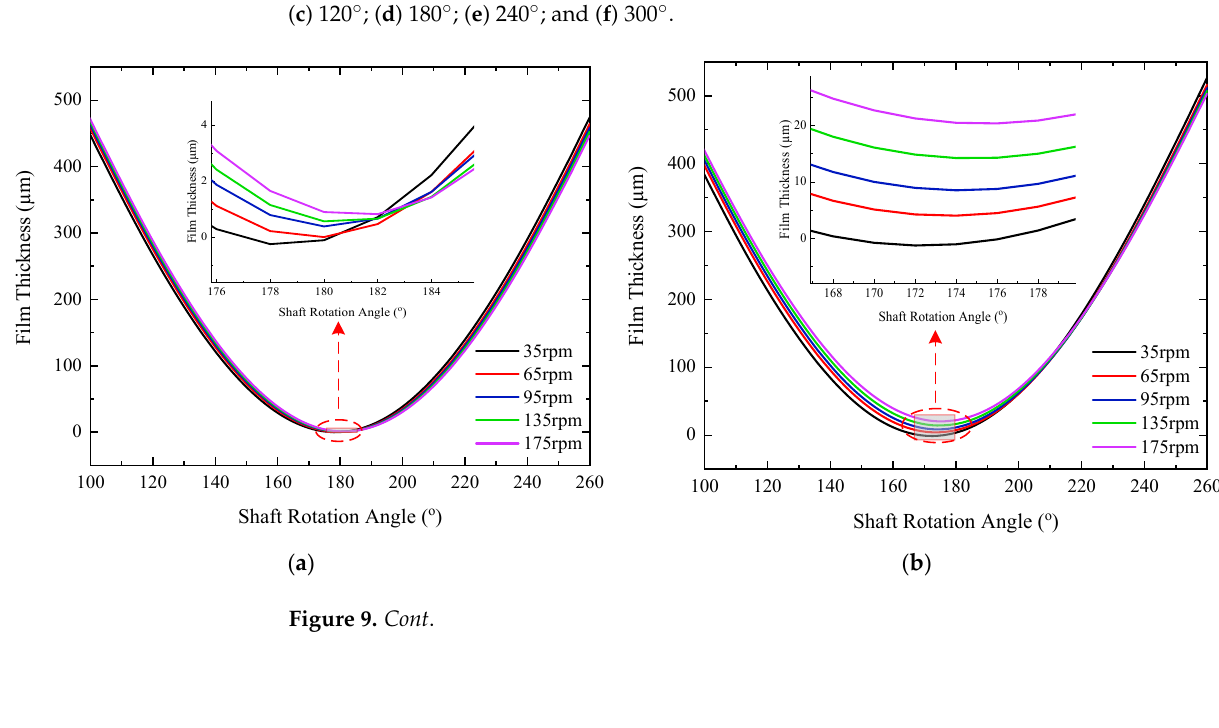
Figure 8. Film thickness at each angle of sections D 1 ~D 3 at 95 rpm and 175 rpm: ( a ) 0°; ( b ) 60°; ( c ) 120°; ( d ) 180°; ( e ) 240°; and ( f ) 300°.